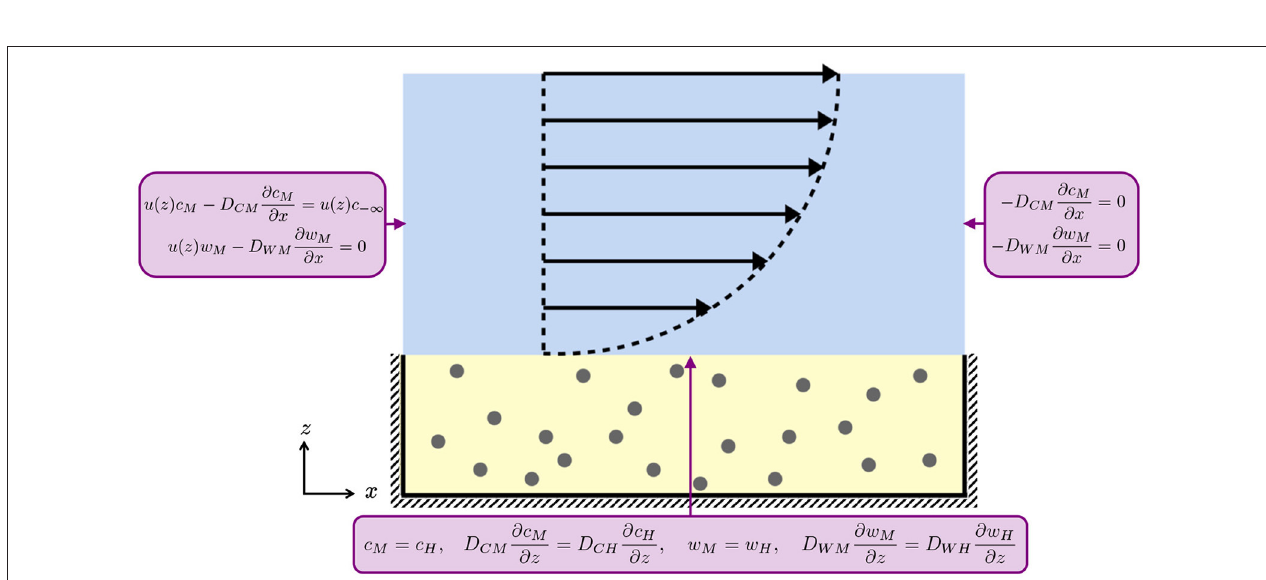
FIGURE 2 | Schematic of the boundary conditions for the media (blue) and hydrogel (yellow) layers for Equations (2.1), (2.2), (2.6), and (2.7). At the media-hydrogel interface, we impose continuity of concentration and flux. At the air-media interface and at the impermeable hashed boundaries, we impose no flux. The black arrows indicate the half-Poiseuille flow